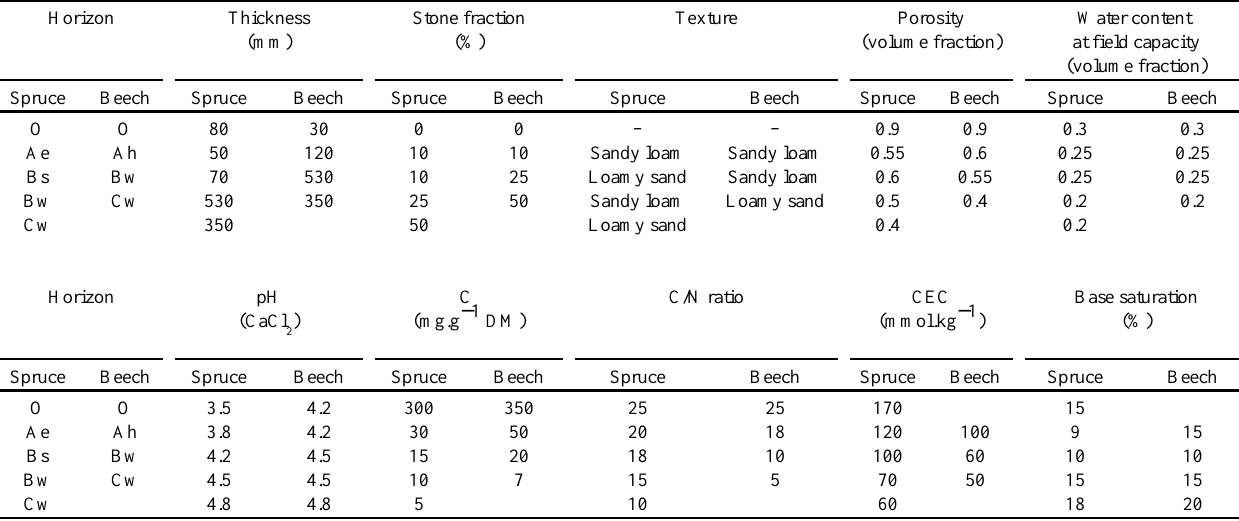
Horizon Thickness